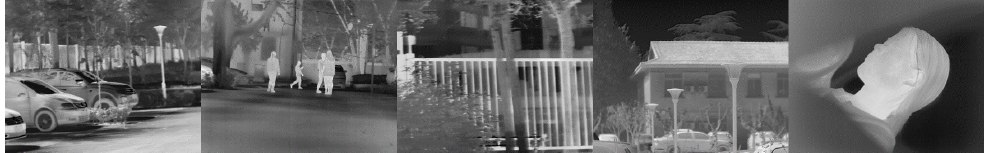
Figure 5. Representative infrared images captured by the cooled mid-wave infrared camera (TB- M640-CL). The features of most images are not